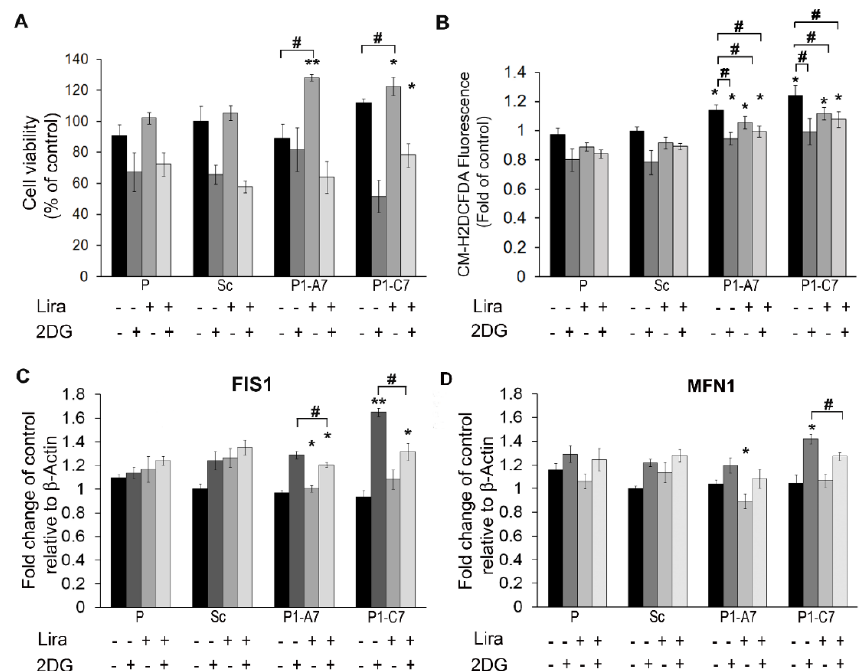
Figure 4. Lira treatment alleviated toxic effect of impaired glycolysis by 2DG. ( A ) Cell viability was evaluated by MTT assay in cells treated with or without 100 nM Lira for 5 h and then treated with / without 50 mM 2DG for 1 h. Cell viability is expressed as percentage respect to that of Sc. ( B ) ROS levels were evaluated in cells treated with or without 100 nM Lira for 5 h and then treated with / without 50 mM 2DG for 1 h. ROS production was measured by CM-H2DCFDA fluorescence intensity and expressed as fold change respect to Sc. ( C , D ) Quantitative evaluation of mRNA expression level of FIS 1 and MFN 1 genes, respectively, in cells treated with or without 100 nM Lira for 5 h and then treated with / without 50 mM 2DG for 1 h. Results are expressed as mean values ± SD. * p < 0.05; ** p < 0.01 vs. Scramble. # p < 0.05 within the clone.